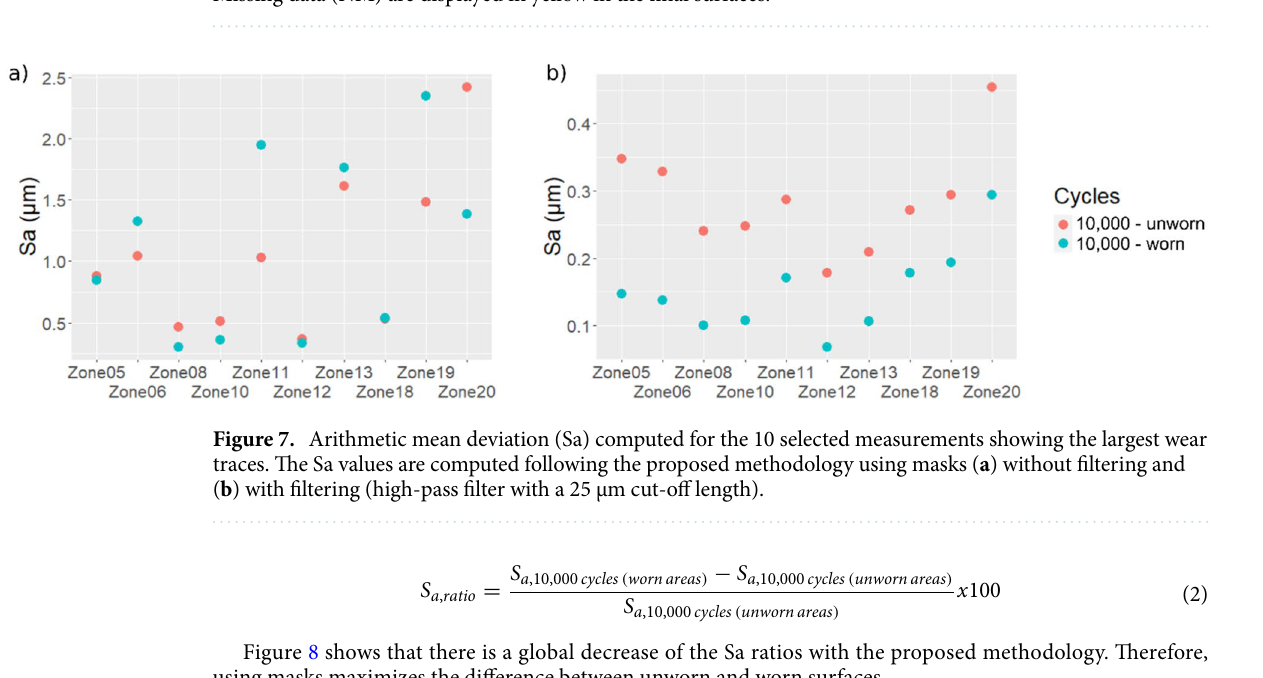
Figure 6. Methodology description to separate worn areas from non-worn areas. Manual tresholding is applied on the grey level distribution of the photo simulation image in order to control the selection of the worn and unworn surface and create corresponding masks. Then, masks are applied on the height map to produce two datasets: one containing data of the worn part of the surface and another one with the data of the unworn part. Missing data (NM) are displayed in yellow in the final surfaces.